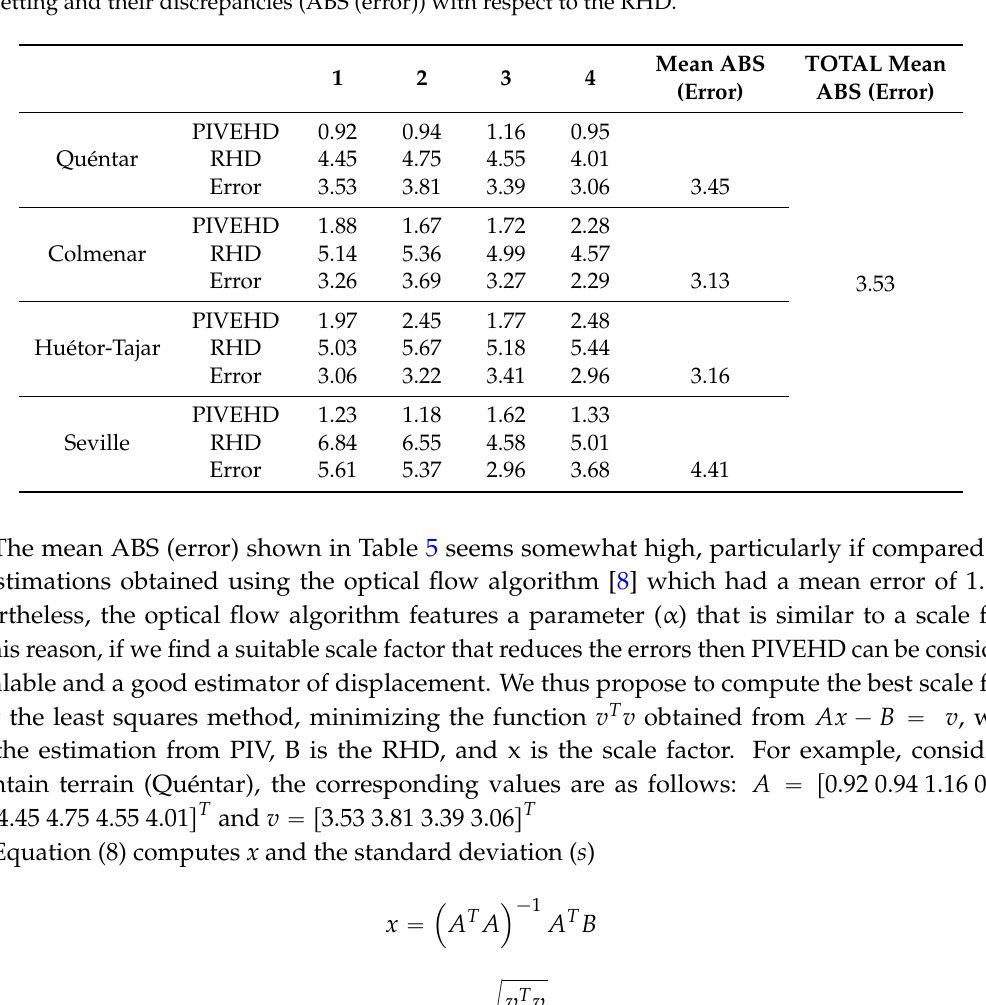
Table 5. PIVEHD from a Medium (pass 1:32 ˆ 32; pass 2:16 ˆ 16; pass 3:8 ˆ 8) interrogation window setting and their discrepancies (ABS (error)) with respect to the RHD.